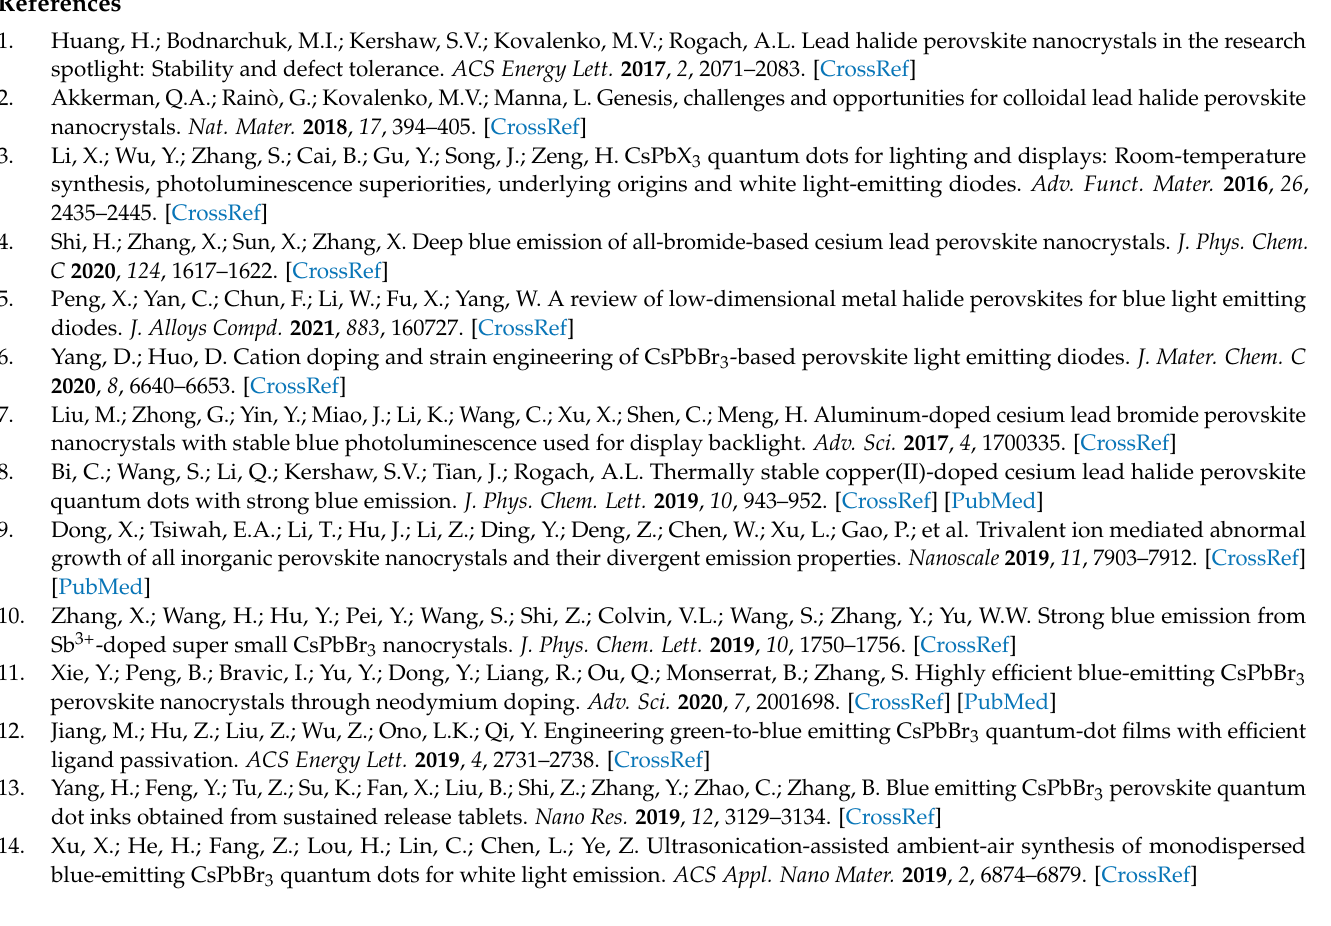
LARP method; Figure S2: Molecular structure and calculated dipole moments of chemicals used in the prepolymer preparation and toluene; Figure S3: Particle size distributions of the CsPbBr 3 Figure S4: Rietveld refinement of X-ray diffraction patterns of ( a ) prepolymer-0, ( b ) prepolymer-25, ( c ) prepolymer-50, and ( d ) toluene-25; Table S1: Compositional ratio of the samples calculated from the Rietveld refinements of the XRD